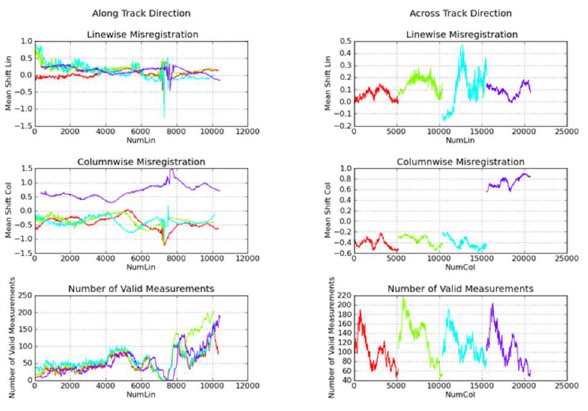
Figure 10 Misregistration profiles of DUCK image obtained with filtered attitude without attitude correction.